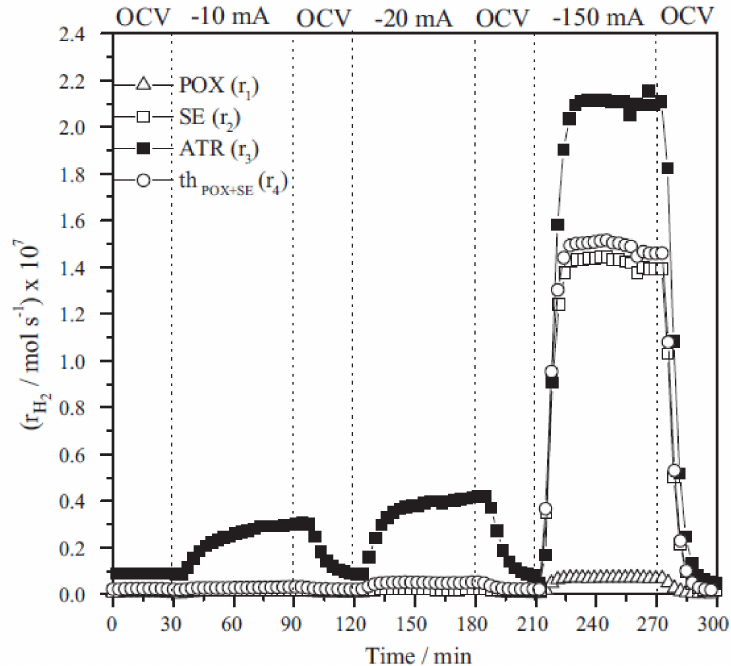
Figure 7. H 2 , molar flow rates vs. time during di ff erent galvanostatic transitions with a Pt-YSZ / YSZ electrochemical catalyst at 600 ◦ C and under di ff erent reaction atmospheres: 1% CH 4 / 0.2% O 2 (POX), 1.5% H 2 O / 0.2% O 2 (SE) and 1% CH 4 / 1.5% H 2 O / 0.2% O 2 (ATR). The joint contribution of POX and